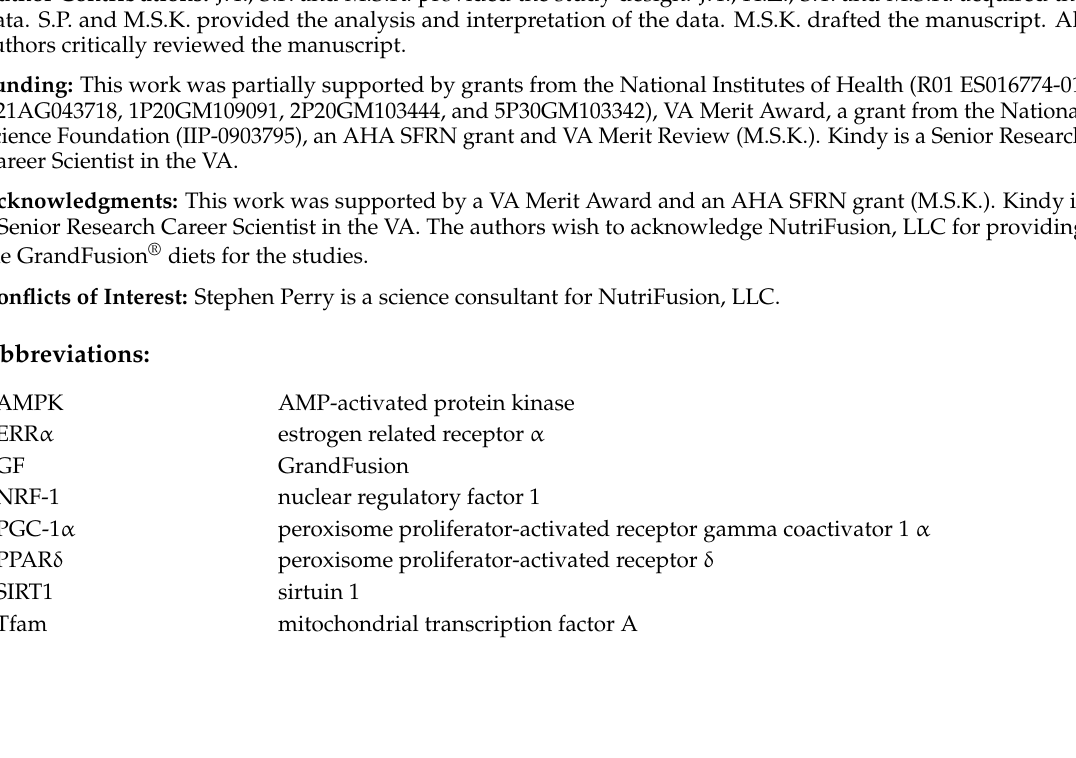
Table S1: Composition of GrandFusion